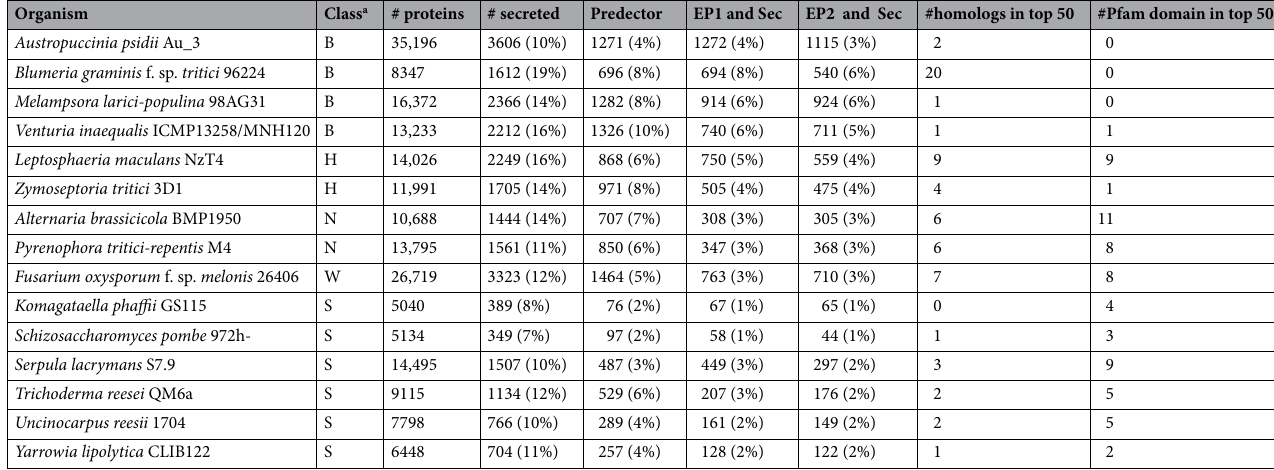
Table 2. Predector results on pathogen and saprobe proteomes held out of the training set. Class indicates the lifestyle of the fungus. Proteins were considered to be secreted if they have a secretion signal predicted by any method and fewer than two predicted transmembrane domains. Predector indicates the number of proteins with a Predector ranking score > 0. EffectorP 1 (EP1) and 2 (EP2) predictions were conditional on secretion and used the default 0.5 decision threshold. The number of protein sequence similarity matches to known effectors and matches to Pfam domains with putative virulence functions are noted for the top 50 candidates by ranked by Predector scores. a Main lifestyle classes of each fungus. B Biotroph, H Hemibiotroph, N Necrotroph, W Wilt, S